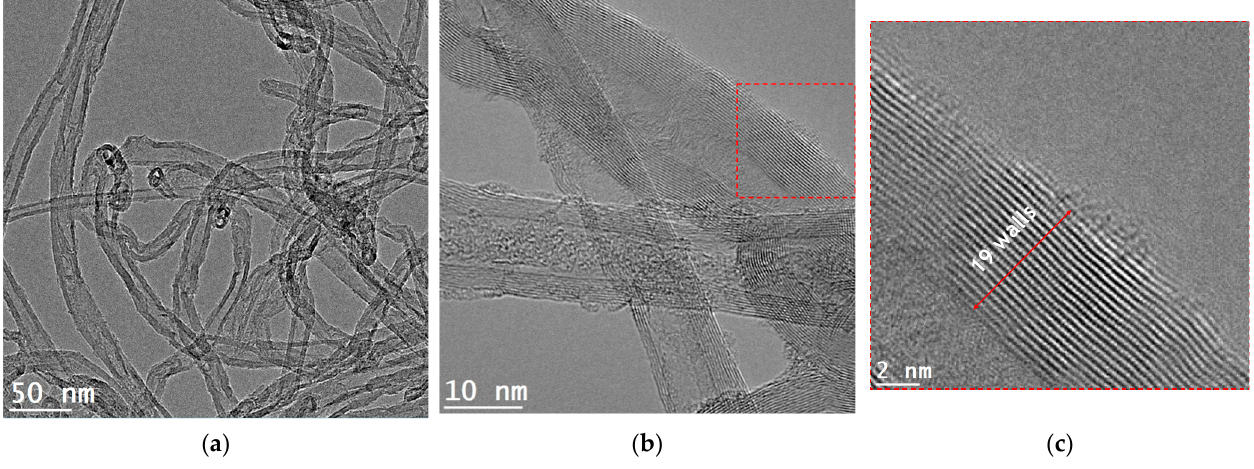
Figure 2. Transmission electron microscopy (TEM) and high-resolution TEM (HRTEM) images of CNTs. ( a ) TEM image of dispersed CNTs, ( b ) HRTEM of the CNTs, and ( c ) a HRTEM detail showing the number of walls in a CNT.